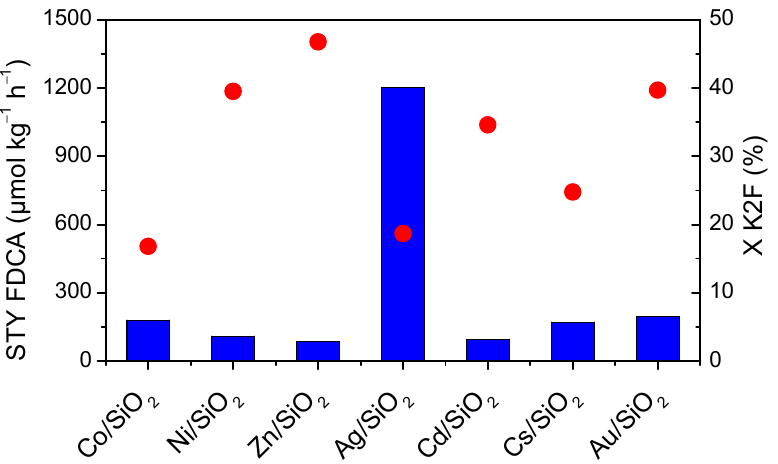
Figure 4. Effect of the metal, using SiO 2 supported catalysts on the conversion ( ● ) of K2F and the STY of 2,5-FDCA ( ■ ). (Conditions: Substrate/M = 9, F CO2 = 45 mL min − 1 , 20 rpm, T = 200 °C, t = 20 h).